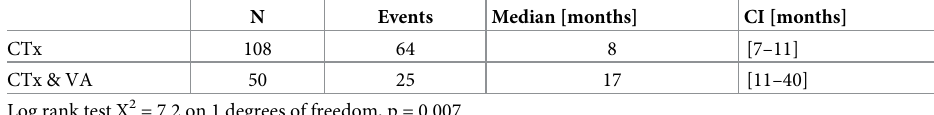
Table 4. Median overall survival of patients with stage IV